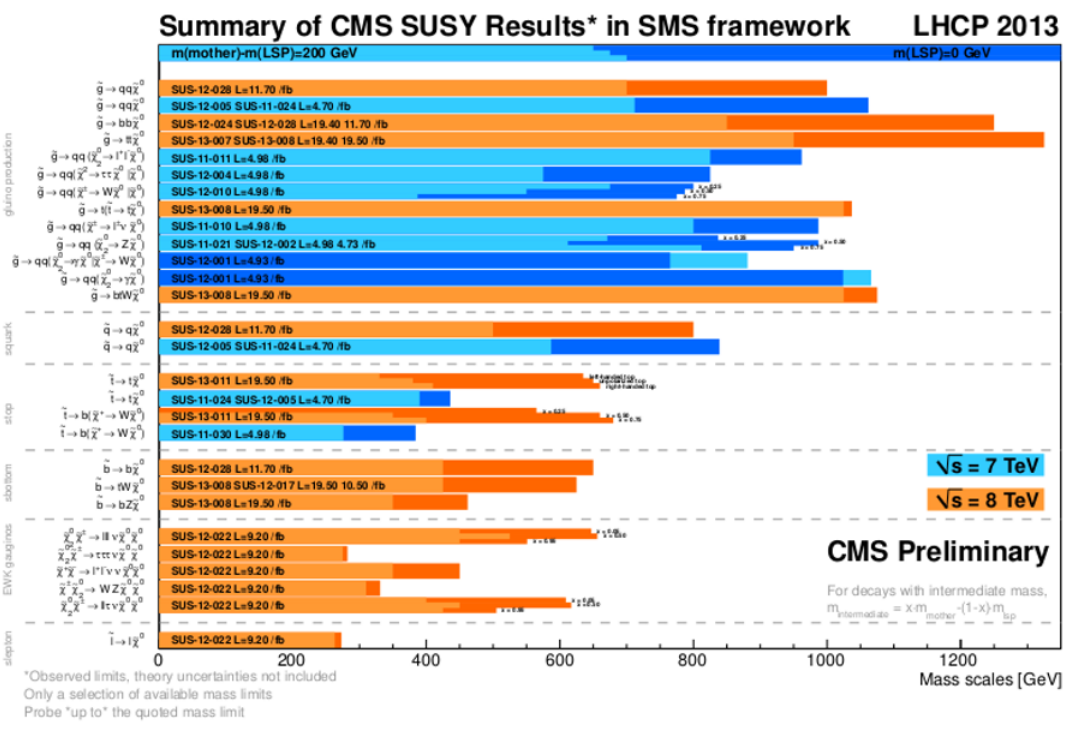
Figure 1. Updated limits on supersymmetric particles masses obtained by the CMS collaboration. Similar bounds are obtained by the Atlas collaboration. See [9, 10] for